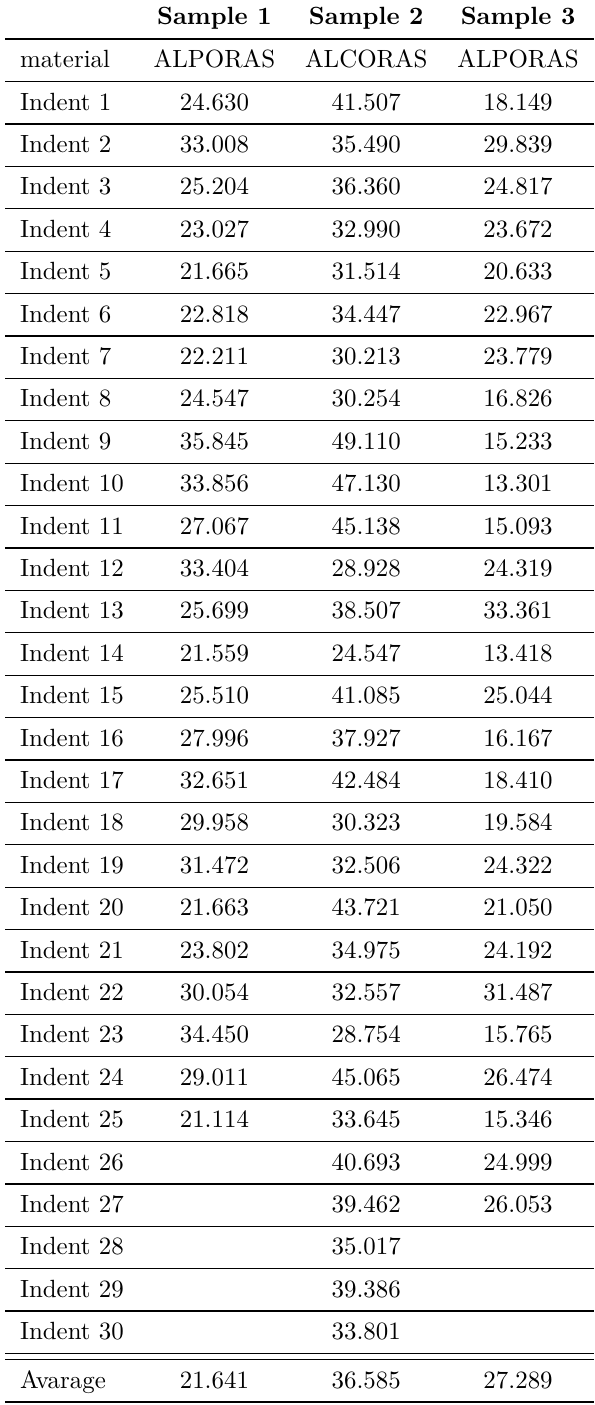
Table 2. Values of measured Vickers hardness